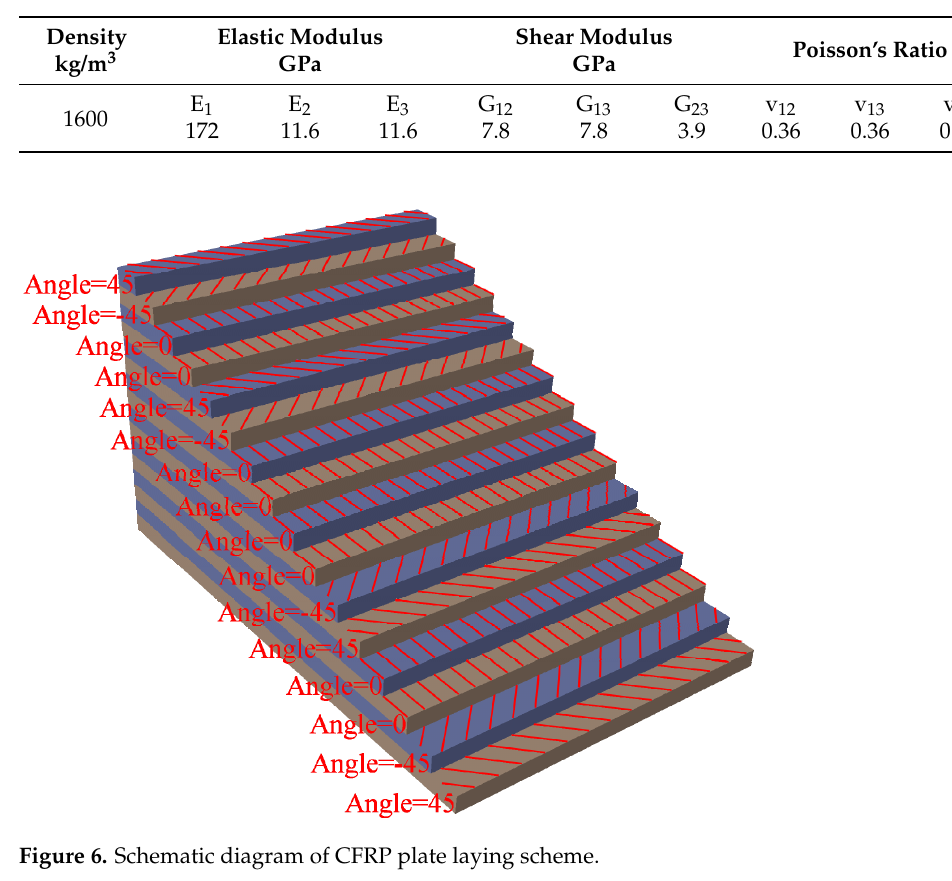
Figure 6. Schematic diagram of CFRP plate laying scheme.